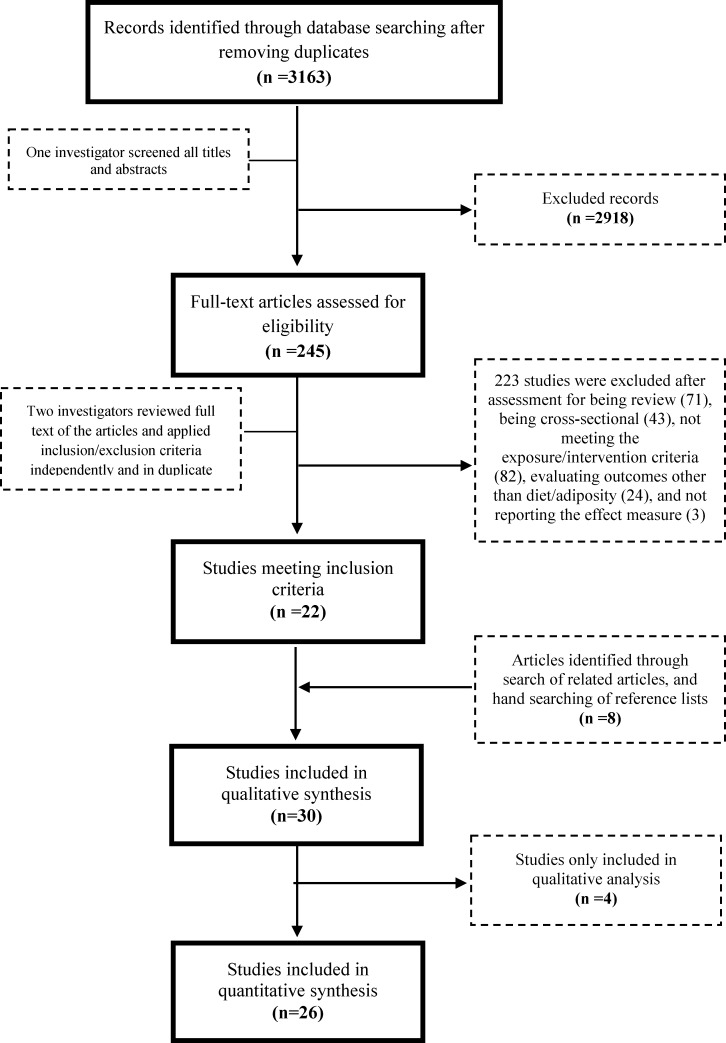
Screening and selection process of interventional trials and prospective observational studies evaluating the relationship between changes in food prices and dietary consumption or adiposity.